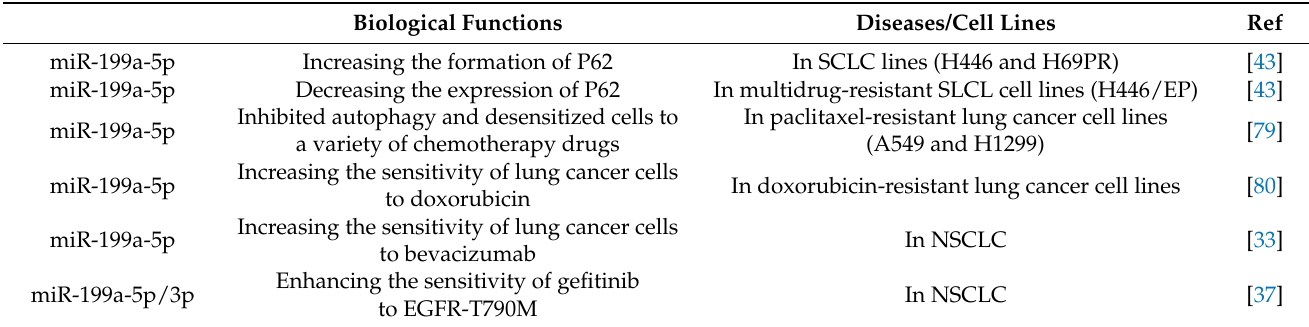
Table 3. miR-199a regulates drug